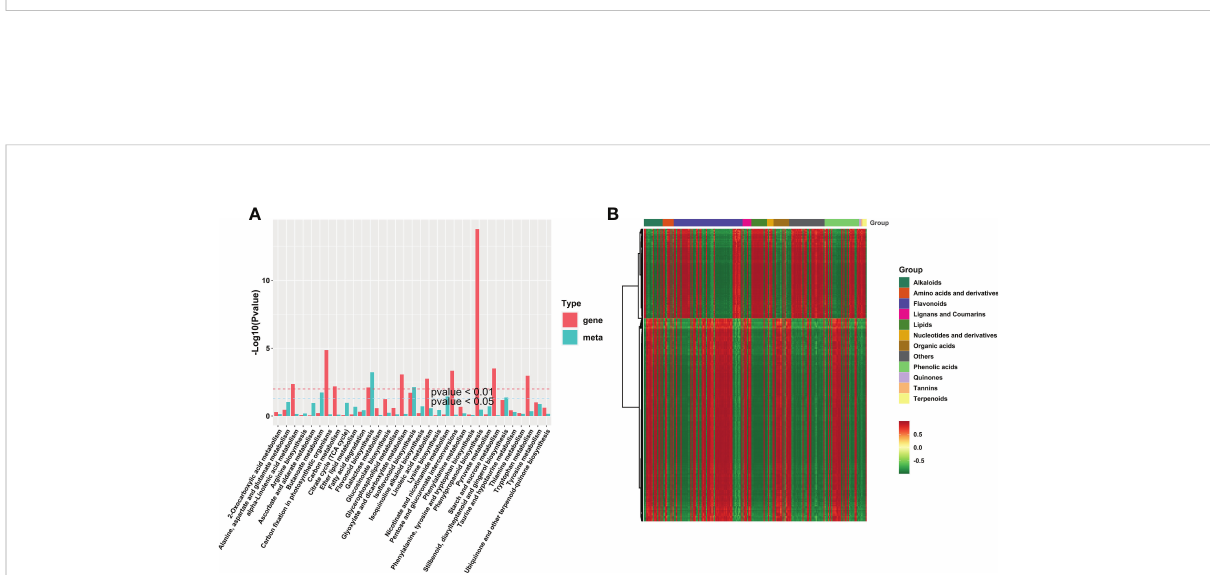
FIGURE 5 Conjoint analysis transcriptome and metabolome. (A) Kyoto Encyclopedia of Genes and Genomes pathway enrichment of DEGs and DAMs. (B) Clustered heat map of DEGs and DAMs. DAMs, differentially accumulated metabolites; DEGs, differentially expressed genes.